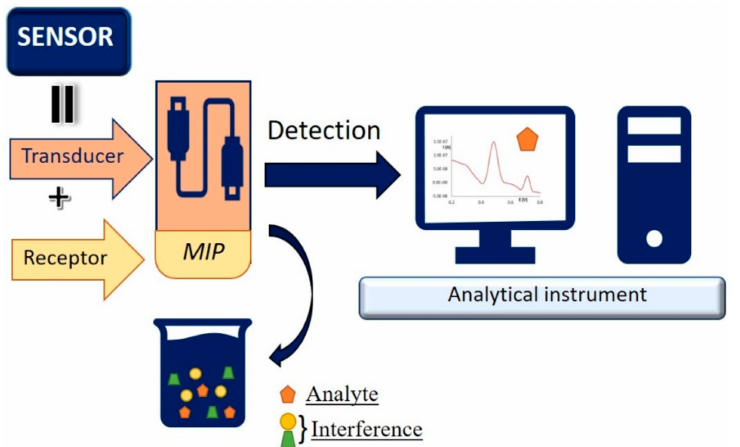
Figure 3. The main constituents of a sensing device: receptor, transducer and analytical